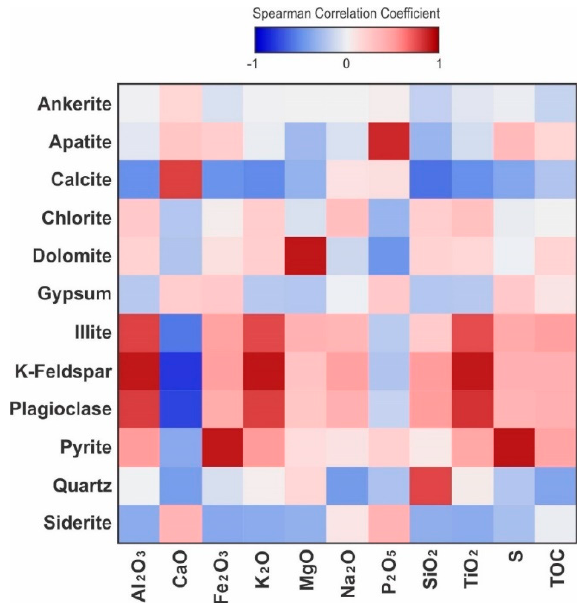
Figure 14. Heat map of the Spearman correlation coefficients between mineralogy and major elements plus TOC from Rock-Eval pyrolysis.